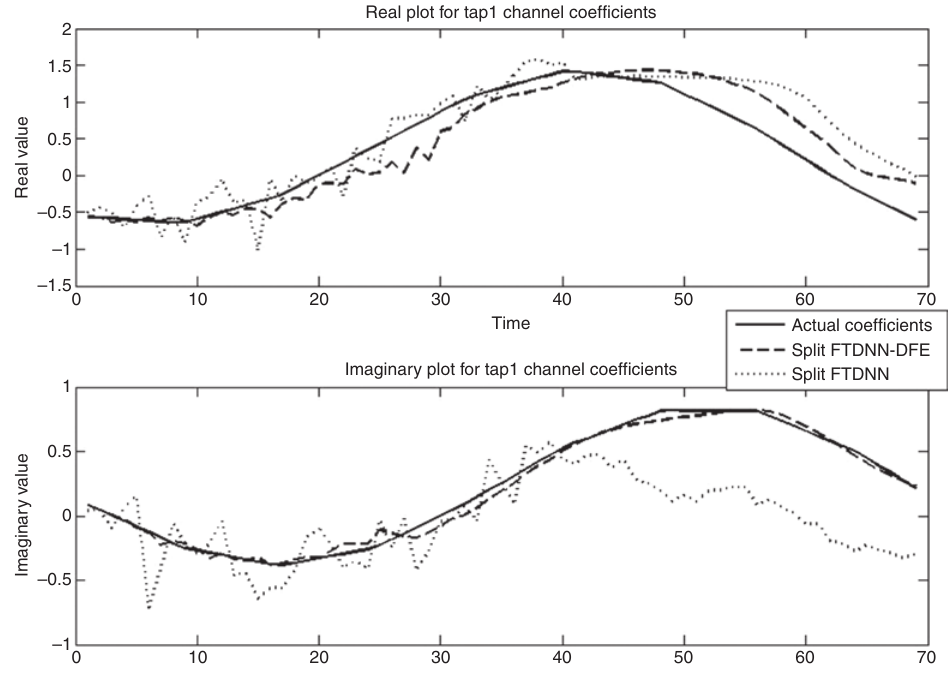
Figure 12: Channel Gain Plot for Case